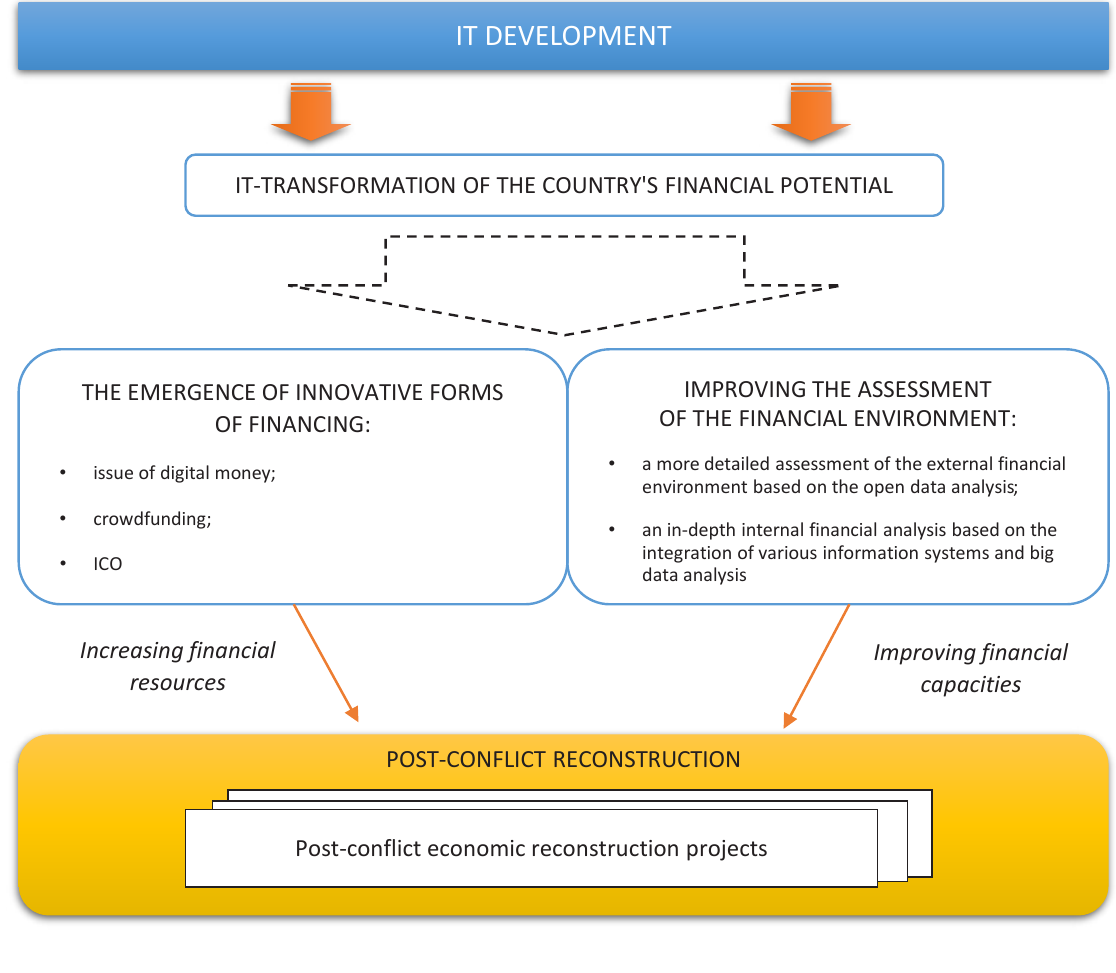
Figure 6. Priority areas of transforming the country’s financial potential through the IT introduction in the context of overcoming the military conflict